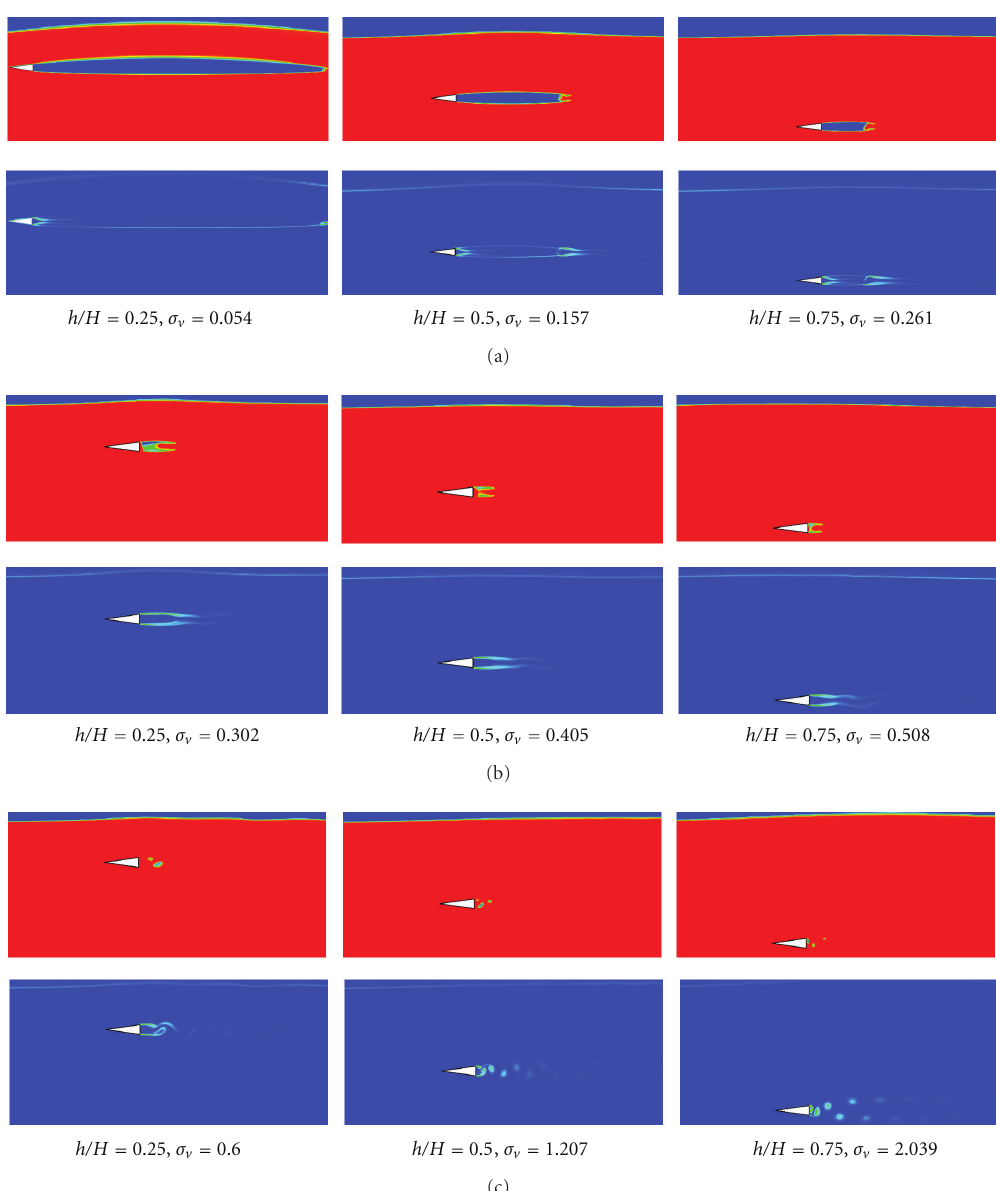
Figure 2: Three cavity patterns: (a) steady type; (b) transition type; (c) wake-vortex type; the upper is the contour of the volume fraction of water; the lower is the contour of the magnitude of the